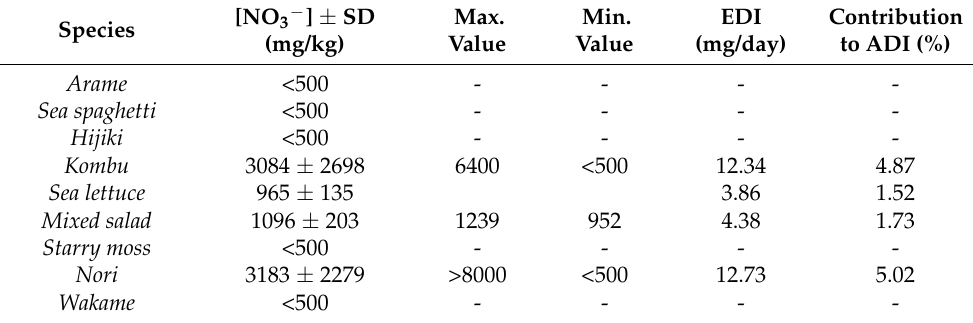
Table 7. Concentration of nitrates (mg/kg), standard deviations (SD), estimated daily intake, and contribution to the ADI of the analyzed